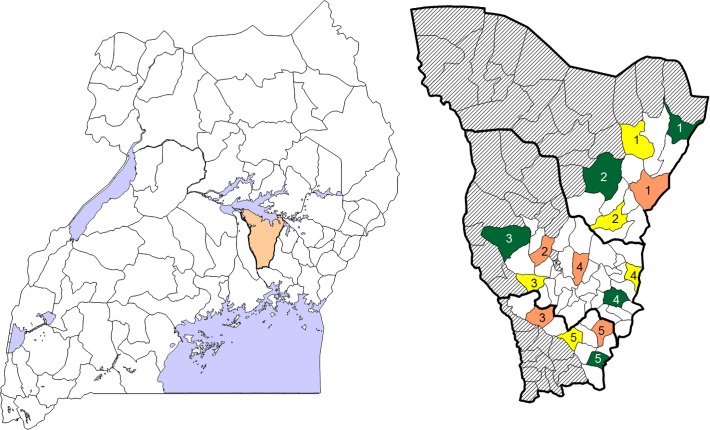
Map of Uganda with Kamuli District (2010 borders) and study clusters (parishes).Numbers represent the five geographical strata; orange: study arm 1; yellow: study arm 2; green study arm 3. Shaded areas were excluded from selection (details see methods section)